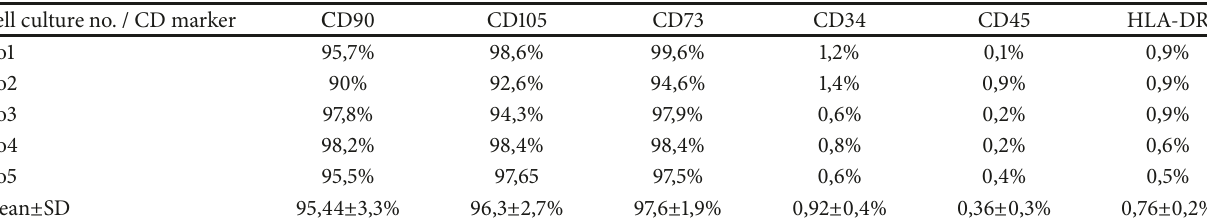
Table 1: Immunophenotype of human